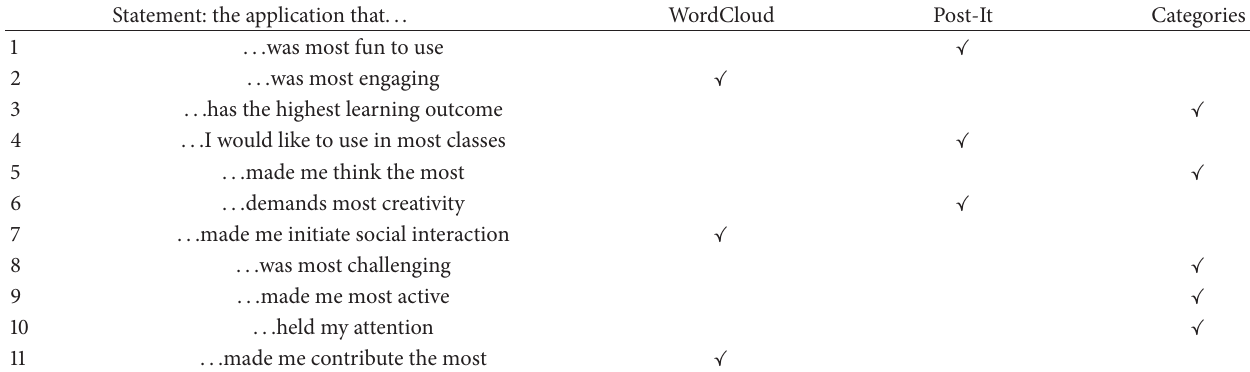
Table 1: Questionnaire for ranking interactive